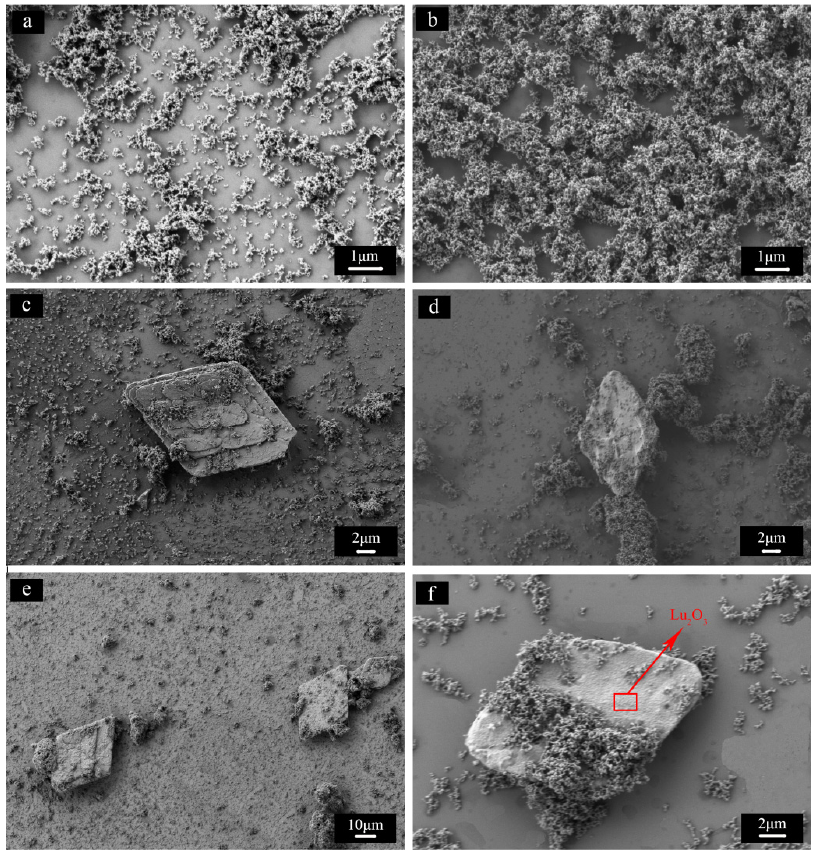
Figure 2. SEM images of the precursors and the resultant powders calcined at 1200 ˝ C for 3 h of S1 ( a and b ), S2 ( c and d ), and S3 ( e and f ).